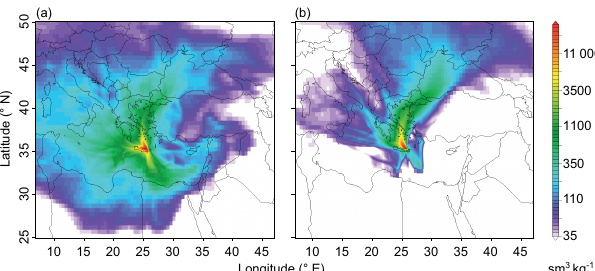
Figure 2. Average FLEXPART-derived source sensitivities for Fi- nokalia and two characteristic flow regimes during the measure- ment campaign: panel (a) shows the variable flow during winter and spring and panel (b) northeasterly flow during the summer months.